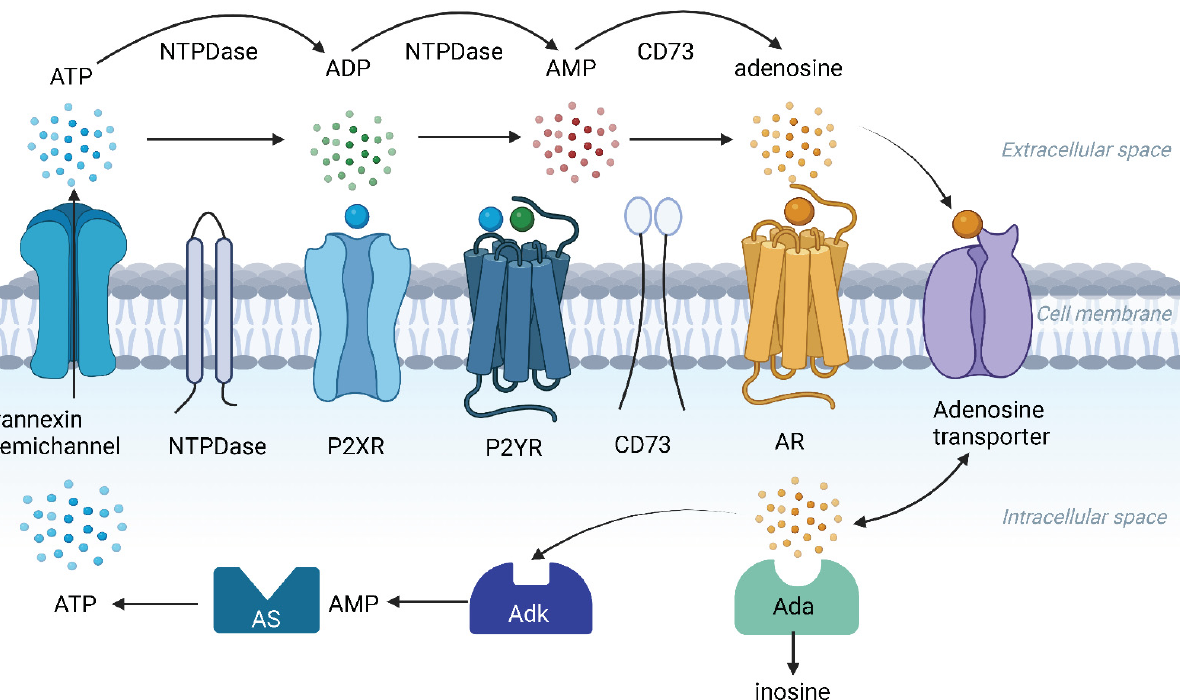
Figure 2. The elements of the purinergic signalling system in the cochlea. Pannexin hemichannels (e.g., Panx1) are the principal conduits of ATP release in the cochlea. Extracellular ATP activates ATP-gated ion channels (P2X receptors) and G protein-coupled receptors (P2Y receptors). ATP is hydrolysed to adenosine 5 (cid:48) -diphosphate (ADP) and adenosine 5 (cid:48) -monophosphate (AMP) by surface-located ecto-nucleoside triphosphate diphosphohydrolases (NTPDases), whereas AMP is dephosphorylated to adenosine by ecto-5 (cid:48) -nucleotidase (CD73). Adenosine activates four types of adenosine receptors (AR: A 1 , A 2A , A 2B and A 3 ). Bi-directional adenosine transporters mediate cellular uptake of adenosine. In the intracellular space, adenosine is hydrolysed to inosine by adenosine deaminase (Ada) or phosphorylated to AMP by adenosine kinase (Adk) and ATP by ATP synthase (AS). Created with